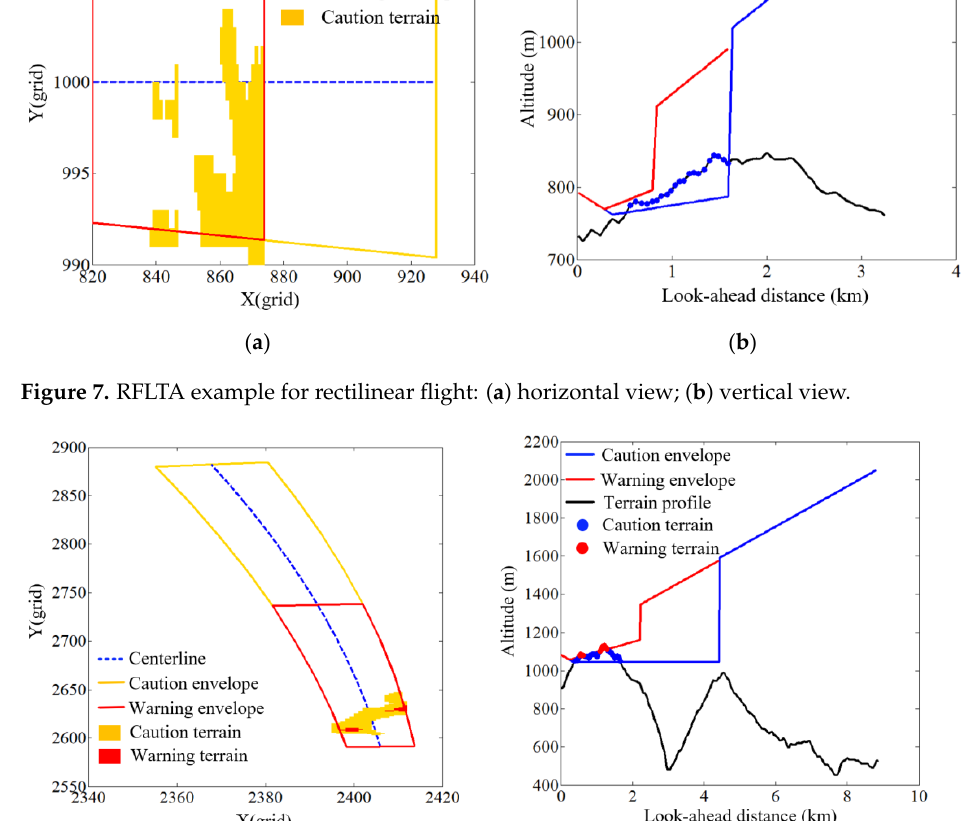
Figure 8. RFLTA example for curvilinear flight: ( a ) horizontal view; ( b ) vertical view.